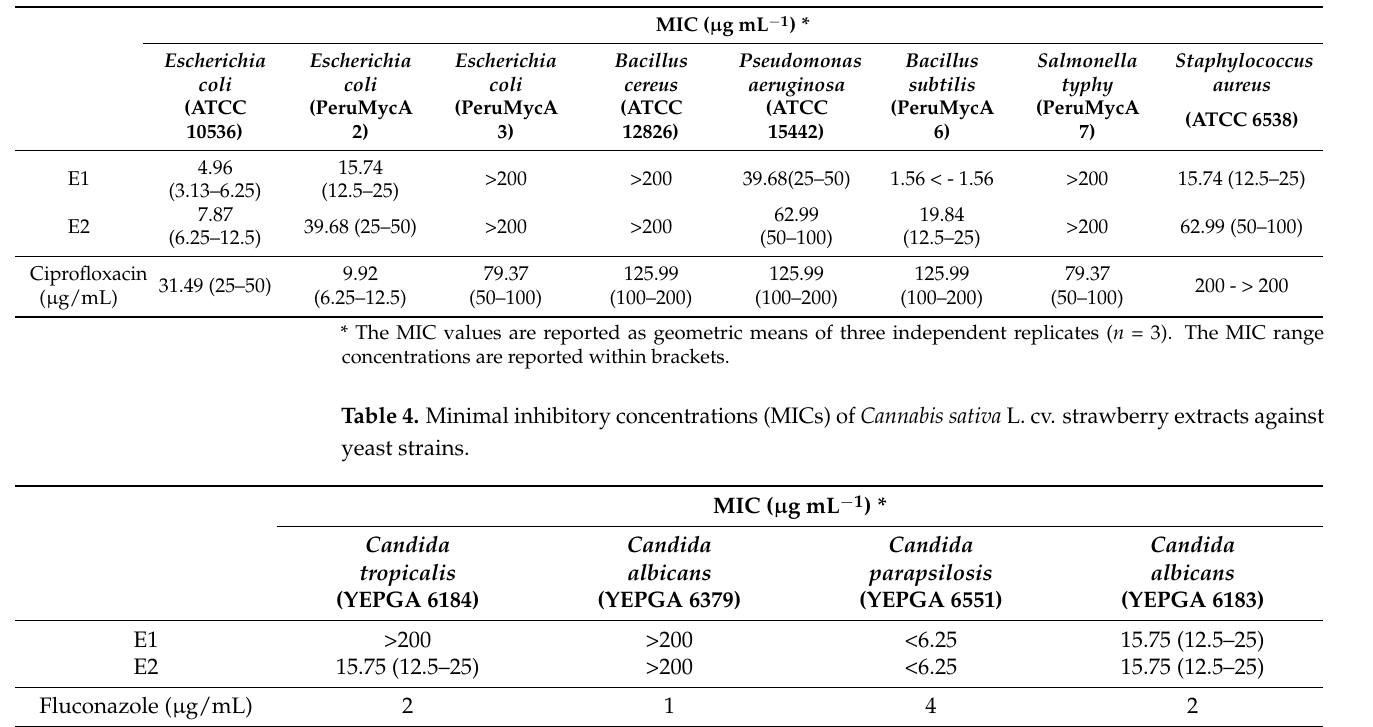
Table 3. Minimal inhibitory concentrations (MICs) of Cannabis sativa L. cv. strawberry extracts against bacterial strains.